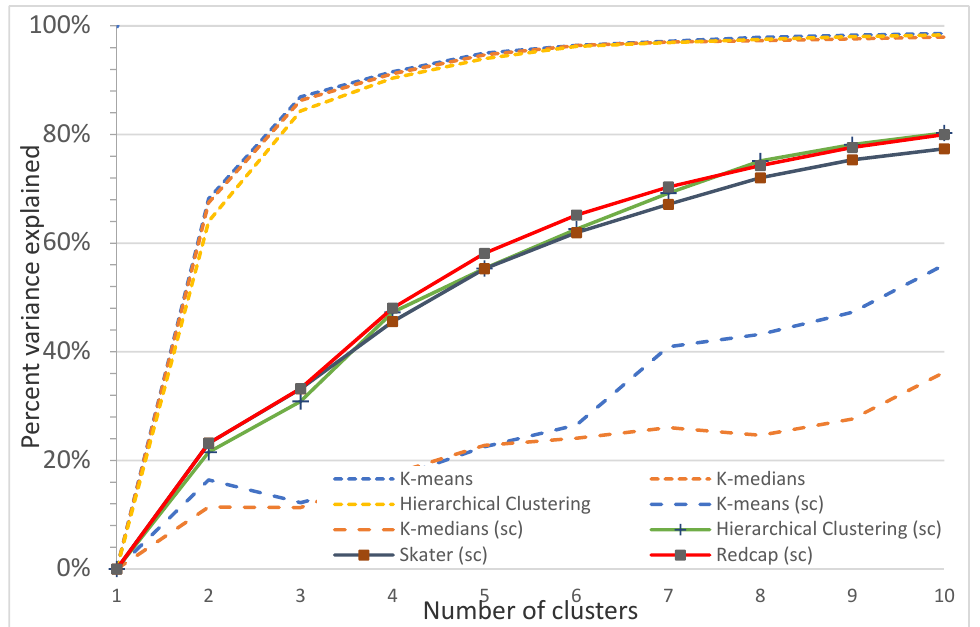
Figure A16. Plot of percentage of the variance explained as a function of the number of clusters generated by eight algorithms for the Koala Coast intra-subregional Group 6 polygon group. This elbow plot indicates that 2 to 3 classes is the optimum, e.g., for nonspatial algorithms, 2 classes explain 86.9% (K-means), 86.3% (K-medians), and 84.3% (Hierarchical clustering) of the variance. For spatial algorithms (sc), there is no clear elbow, with the Redcap algorithm explaining a maximum of 33.2% of the variances for 3 classes.